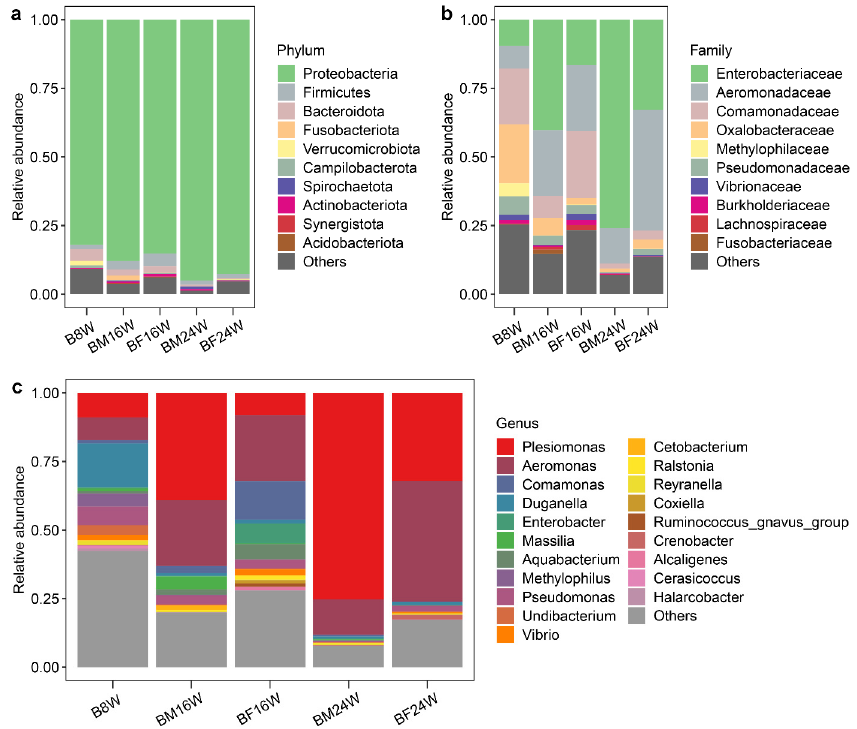
Figure 2. The top abundant gut microbiota in Siamese fighting fish across age and gender groups. ( a , b ) Bar plots of the average relative abundance of the top ten phyla and families. ( c ) A bar plot of the average relative abundance of the top 20 genera. Others are the low relative abundance of ASVs outside the top taxa. B8W, 8-week-old Siamese fighting fish; BM16W, 16-week-old male Siamese fighting fish; BF16W, 16-week-old female Siamese fighting fish; BM24W, 24-week-old male Siamese fighting fish; BF24W, 24-week-old female Siamese fighting